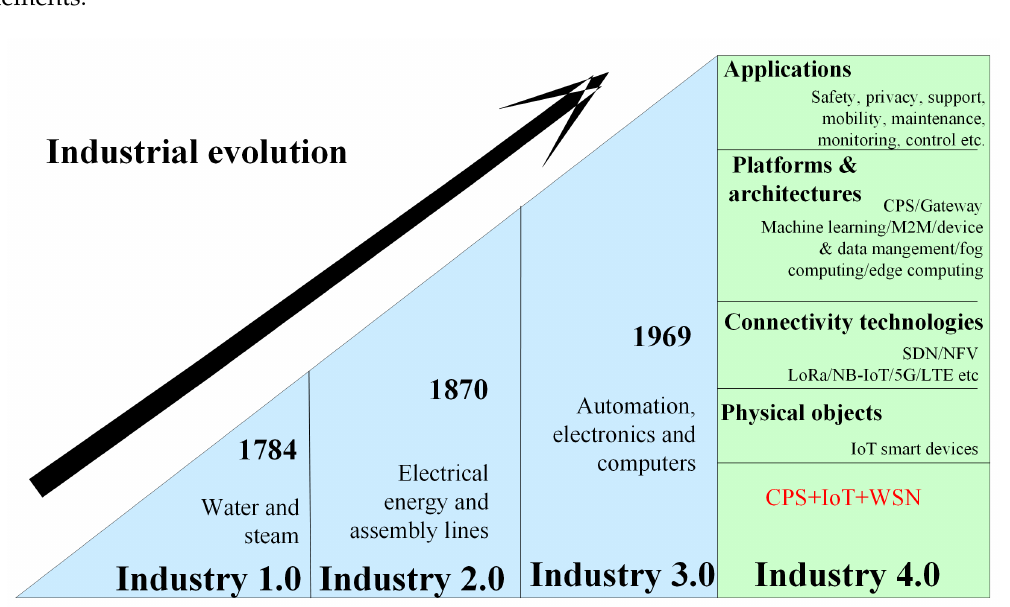
Figure 3. Evolution towards Industry